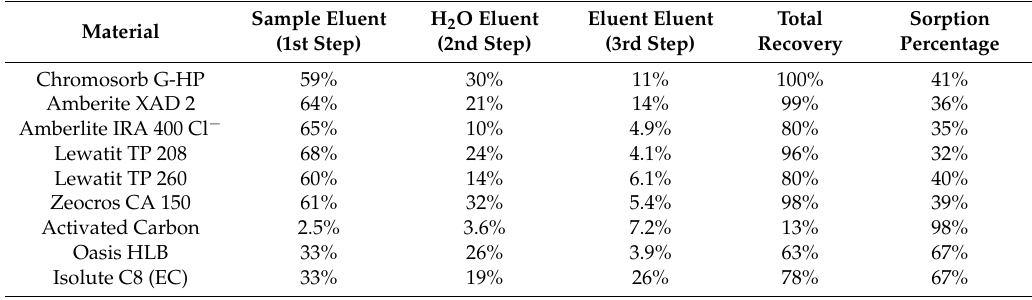
Table 4. Sugars determined in the eluents in comparison with the sugars loaded to the SPE column.